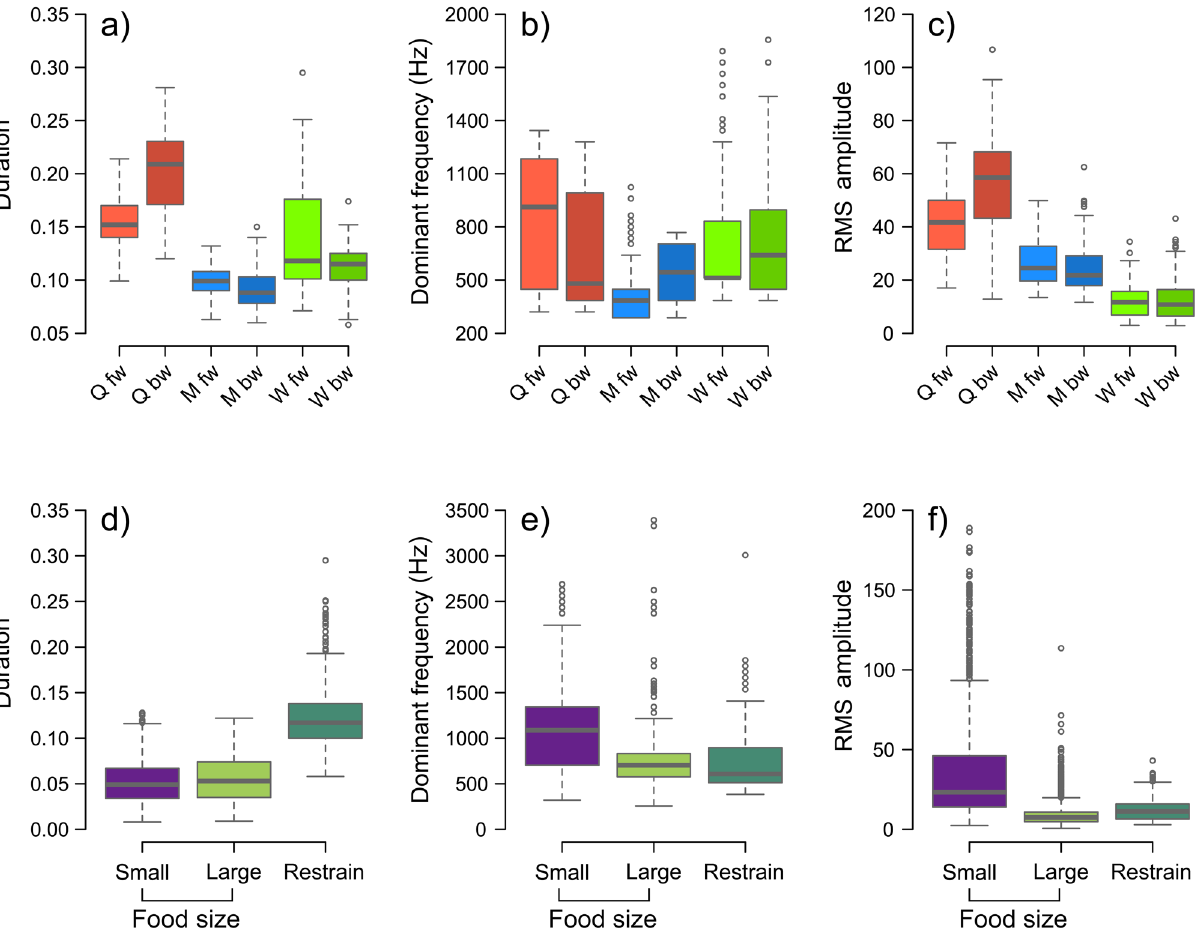
Figure 3. Values of dominant frequency (Hz), Root Mean Squared (RMS) and chirp duration (s) of the substrate-borne vibrations produced by stridulation, for both the restraining and food trials. Q fw : queens’ forward chirp; Q bw : queens’ backward chirp; M fw : males’ forward chirp; M bw : males’ backward chirp; W fw : workers’ forward chirp; W bw : workers’ backward chirp; Large: large honey drop (20 µl); Small: small honey drop (2 µl); Restraining: mean values of chirp parameters emitted by workers during restraining. ( a – c ); comparison of chirp parameter among castes; ( d – f ) comparison of workers’ chirp parameters between different food sizes and in the restraining